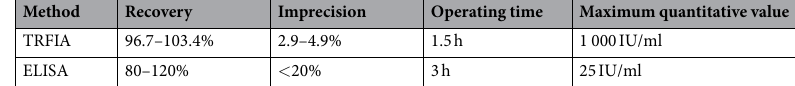
Table 4. Comparison of assay performance for the present TRFIA and